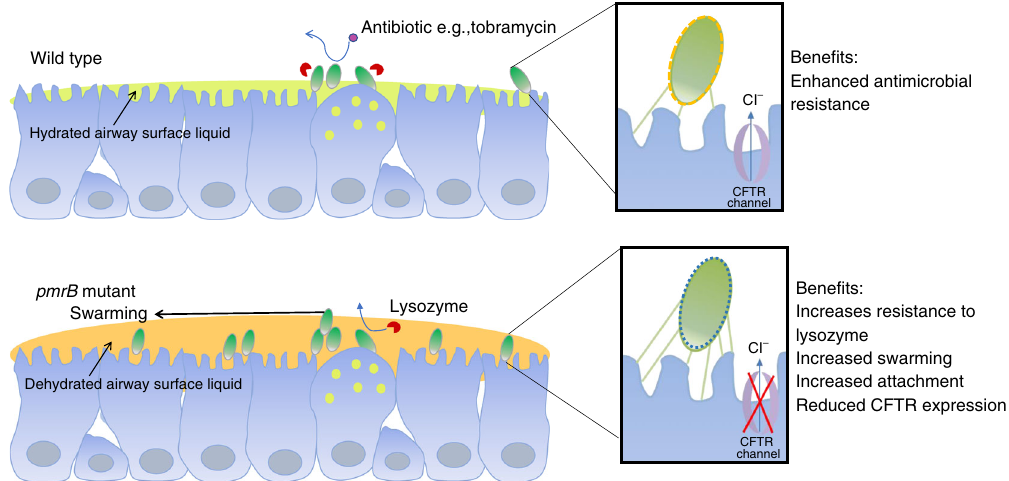
Fig. 8 Proposed mechanism for enhanced infection potential of pmrB mutants. Protein expression changes associated with pmrB mutation may confer an ability to reproduce the phenotypic features of the CF lung via inhibition of host CFTR. Increased expression of type IV pili aids colonisation and adhesion to airway epithelium. Resistance to lysozyme associated with increased ivy production enables persistence in the face of immune pressure. The airway surface liquid is depicted in green for wild type and yellow for the pmrB mutant to denote dehydration resulting from CFTR